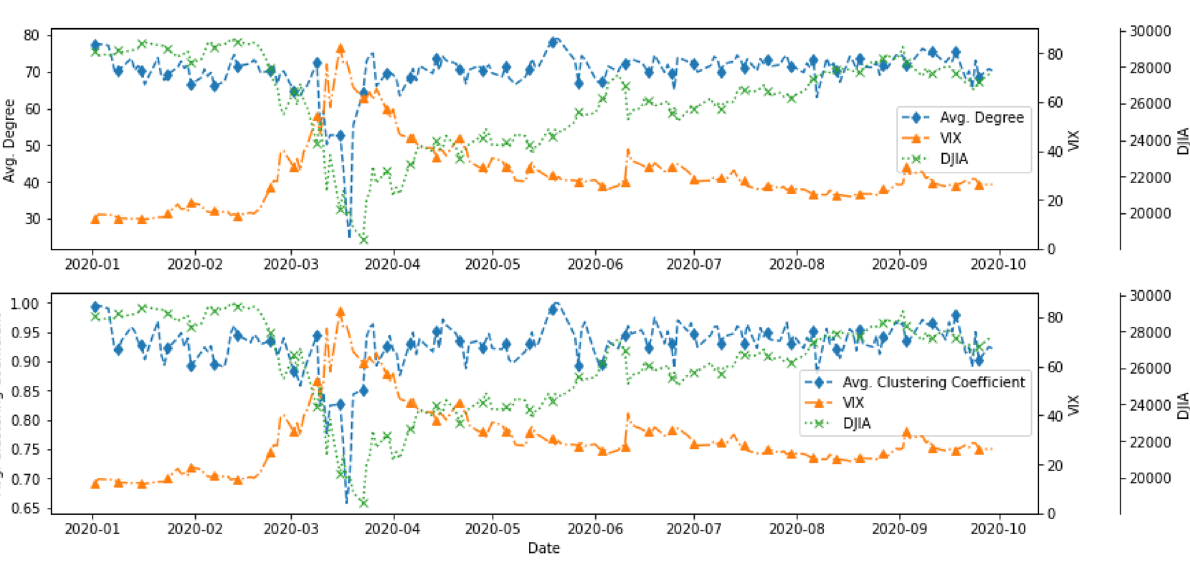
Figure 10. Comparison of network statistics, VIX and DJIA, between 1 January and 30 September